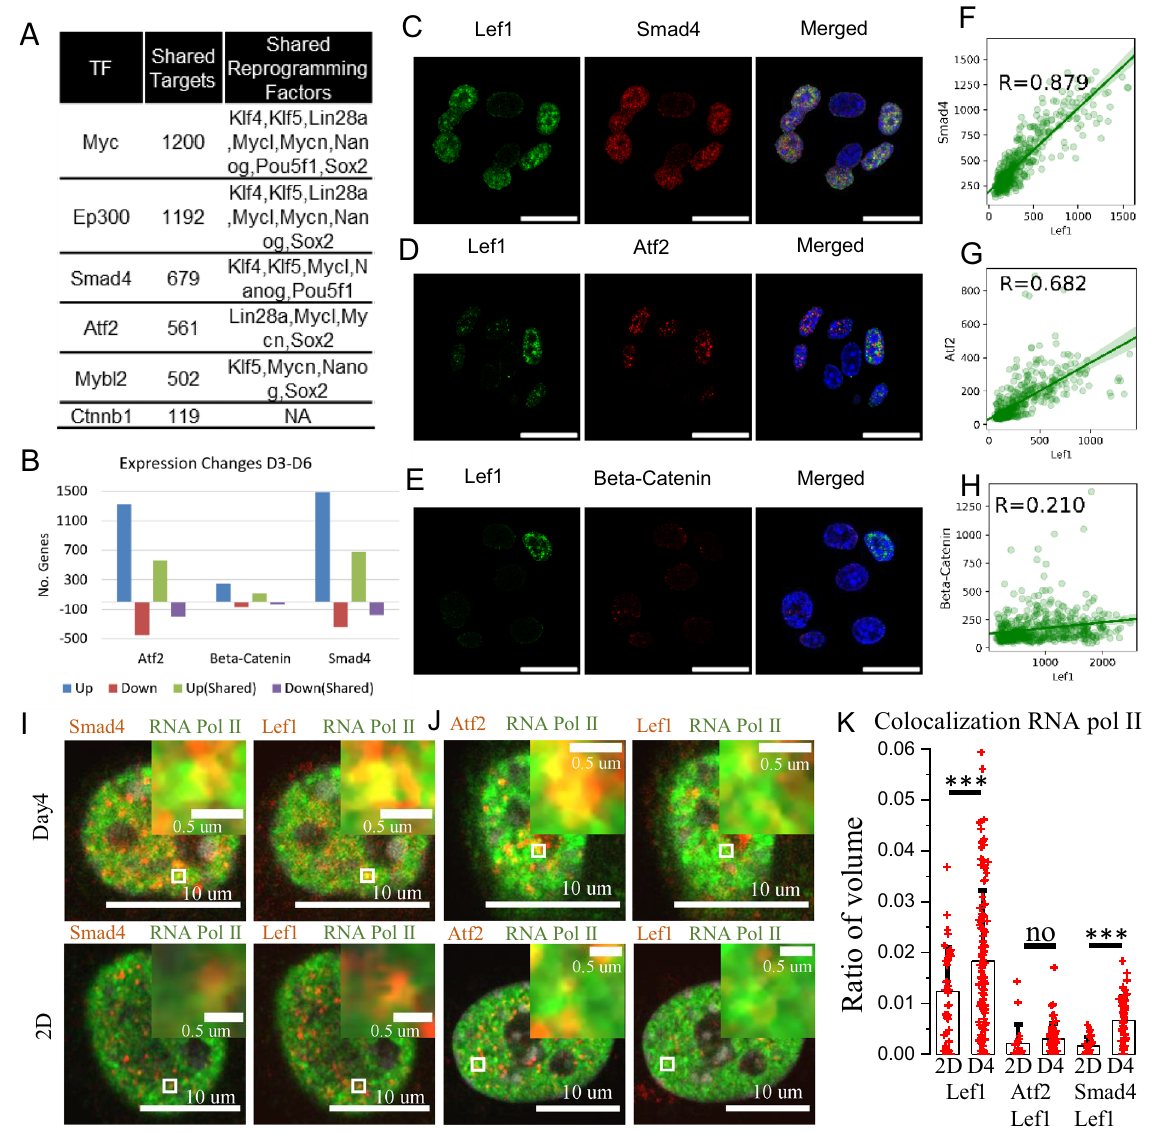
Figure 5. Lef1 activation is potentially regulated by Smad4 and Atf2 pathways. ( A ) Table of identified genes that could interact with Lef1, the number of shared targets with Lef1 and the shared reprogramming factors as targets. ( B ) Bar plot showing the number of genes up-regulated or down-regulated from day3 to day6. Up (Shared): shared targets with Lef1 that are up-regulated. Down (Shared): shared targets with Lef1 that are down- regulated. These targets are differentially expressed with adjusted p value < 0.01. ( C , D , E ) The staining of Lef1, Smad4, and Nucleus; Lef1, Atf2 and Nucleus; and Lef1, Beta-catenin and Nucleus in day4 sample. Scale bar is 20 um. ( F , G , H ) Scatter plots showing the averaged nuclear fluorescence intensity of Lef1 and Smad4; Lef1 and Atf2; and Lef1 and Beta-catenin along with linear fits and the corresponding Pearson correlation coefficients. Representative images of co-staining with Lef1/Smad4/RNA pol II ( I ), Lef1/Atf2/RNA pol II ( J ). The insets are the zoom of small white box regions from the respective images. ( K ) Barplot shows the change of colocalization from 2D culture conditions to D4 (Day4 sample). The unit is the ratio of colocalized volume and the nucleus volume. Each dot represents one nucleus. The first two bars are the colocalization of Lef1 and RNA pol II. The middle two bars are the colocalization of Lef1, Atf2 and RNA pol II. The last two bars are the colocalization of Lef1, Smad4 and RNA pol